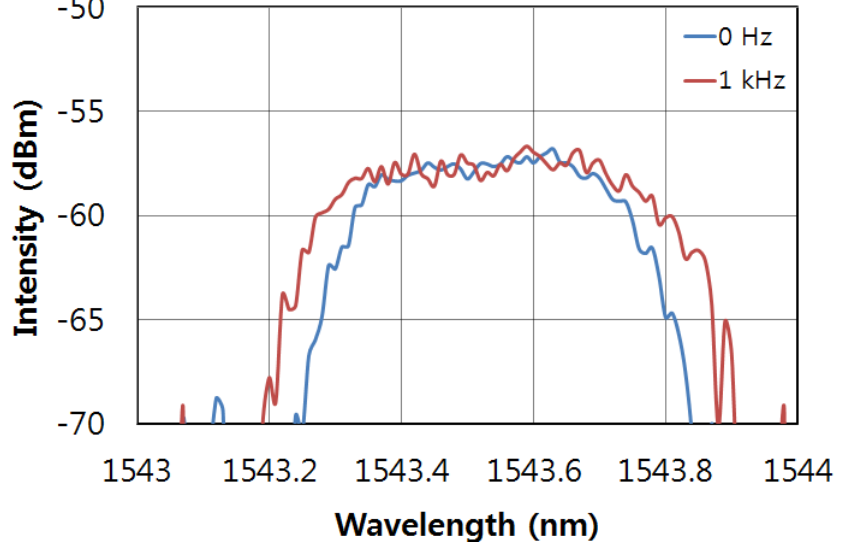
Figure 4. Optical spectrum when dynamic strain (1 kHz) is applied to FBG 3 and in the absence of dynamic strain (0